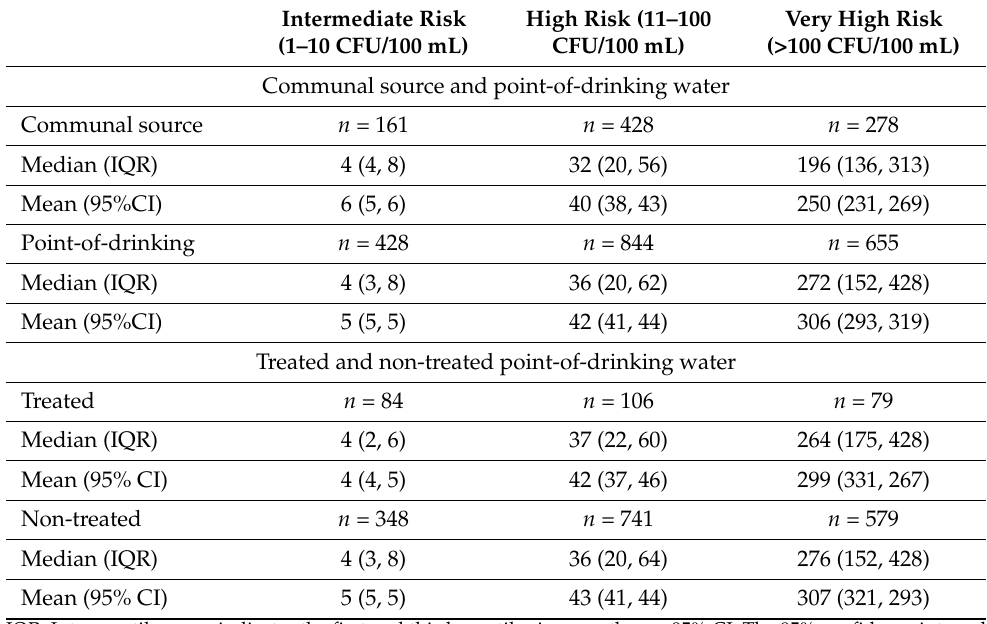
Figure 2. Fecal contamination of drinking water according to WHO risk category. Table 3. Median and mean concentration of E. coli of communal source and point-of-drinking water, and treated and non-treated point-of-drinking water.